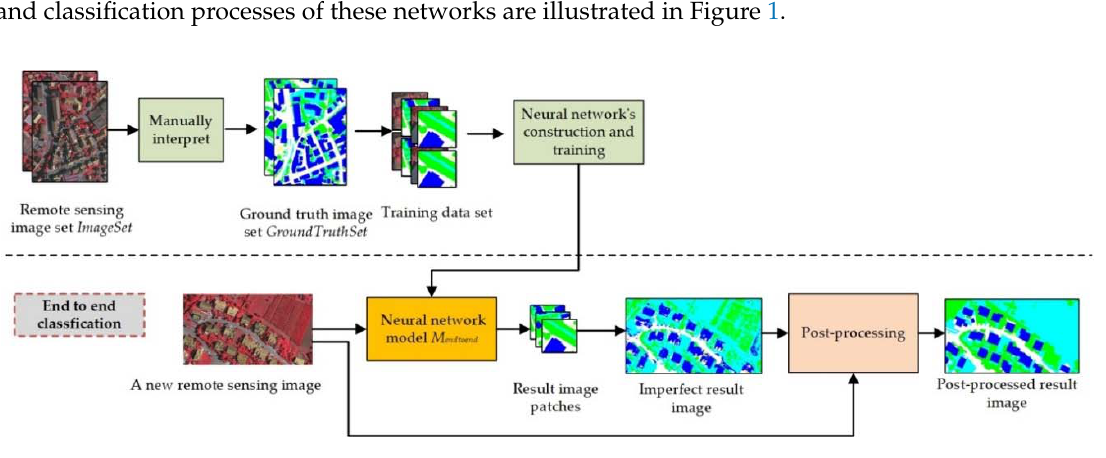
Figure 1. End-to-end classification Figure 1. End ‐ to ‐ end classification strategy.